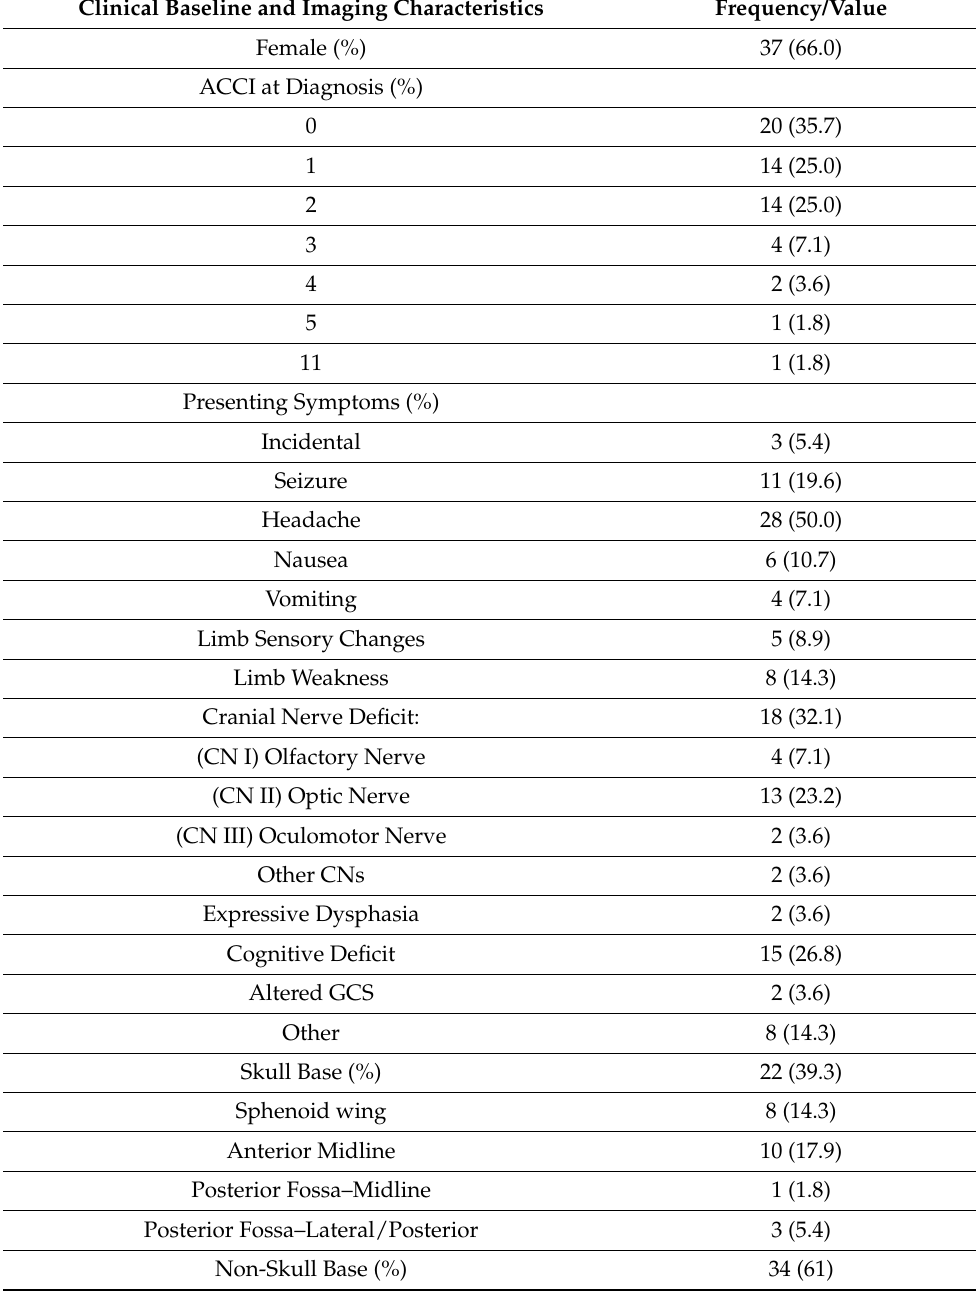
Table 1. Contains baseline clinical and radiological details for the cohort at diagnosis. Clinical Baseline and Imaging